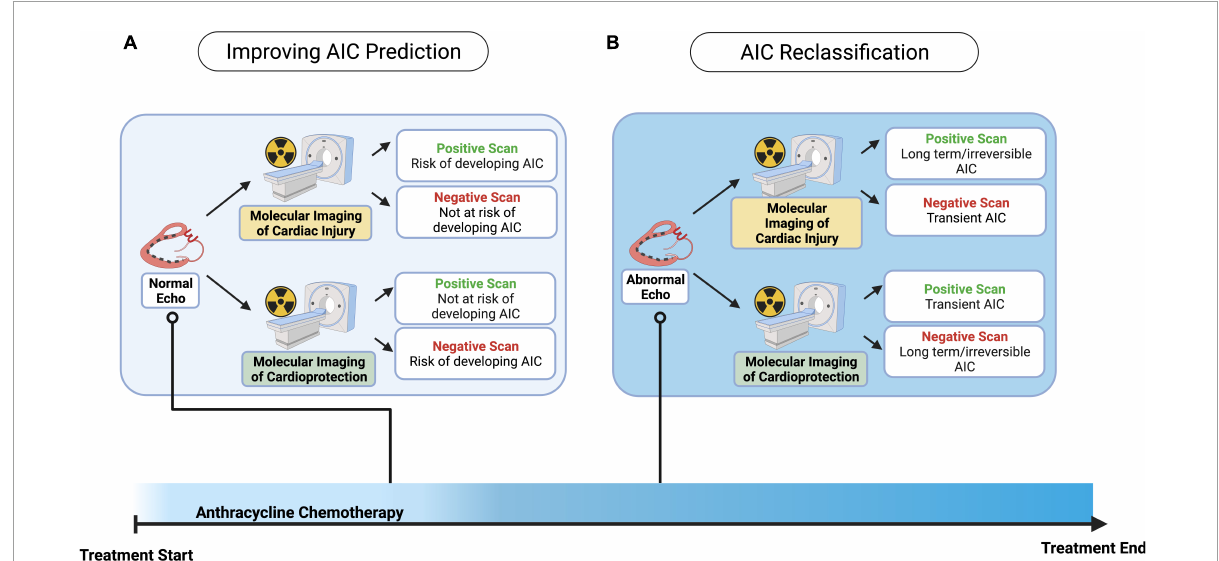
FIGURE3 Potential clinical applications of nuclear molecular imaging in predicting and reclassifying cardiotoxicity in cancer patients undergoing anthracycline treatment. Different clinical algorithms may be followed according to the mechanistic pathway targeted for imaging – whether expression of cardiac injury related proteins, or alternatively activation of cardioprotective pathways – and the presence or absence of abnormal echocardiographic features suggestive of cardiotoxicity. (A) Molecular imaging may be used to predict the risk of developing cardiotoxicity during and/or following anthracycline treatment in patients with a normal echocardiogram. (B) In patients with an abnormal echocardiogram suggesting a new impairment in cardiac function, molecular imaging may be able to finetune the cardiotoxicity diagnosis with implications on the duration of anthracycline-induced cardiac dysfunction, or to reclassify the echocardiographic diagnosis, thereby providing oncologists and cardiologists greater diagnostic certainty with ensuing clinical